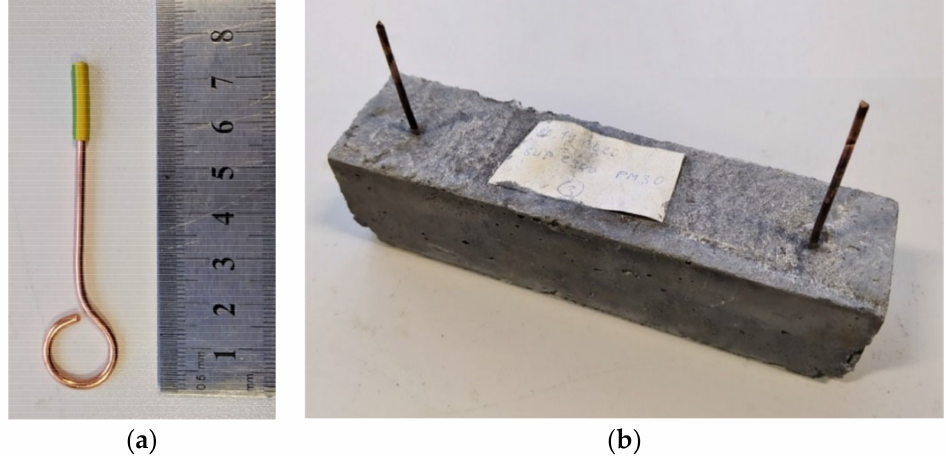
Figure 7. The measuring of impedance: ( a ) a detail of the copper electrode for measuring impedance in test specimens; ( b ) a test specimen with